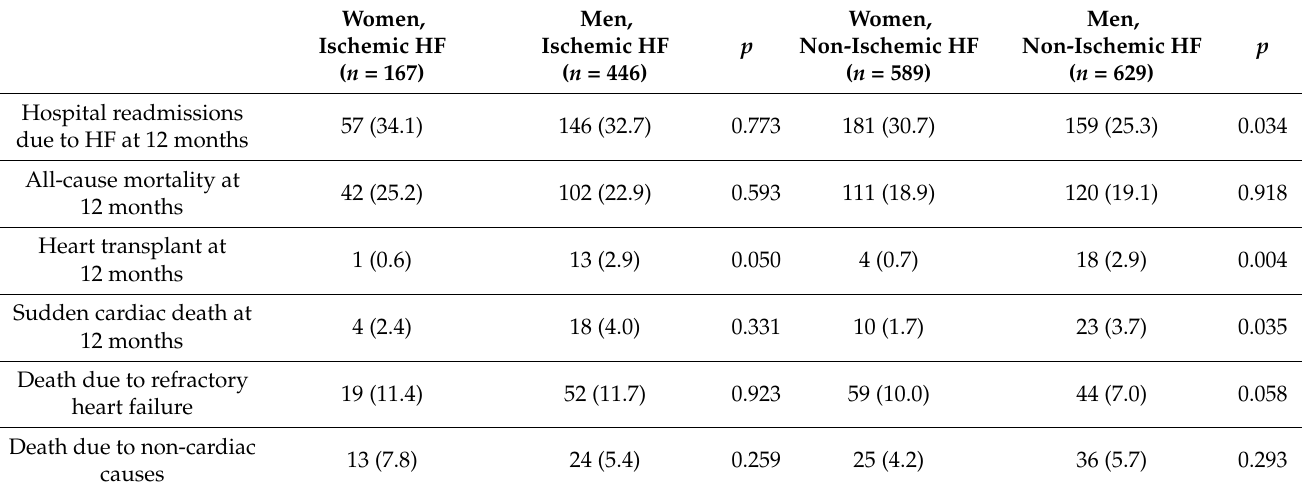
Table 3. Events during follow-up in patients admitted with heart failure (HF) according to etiology and